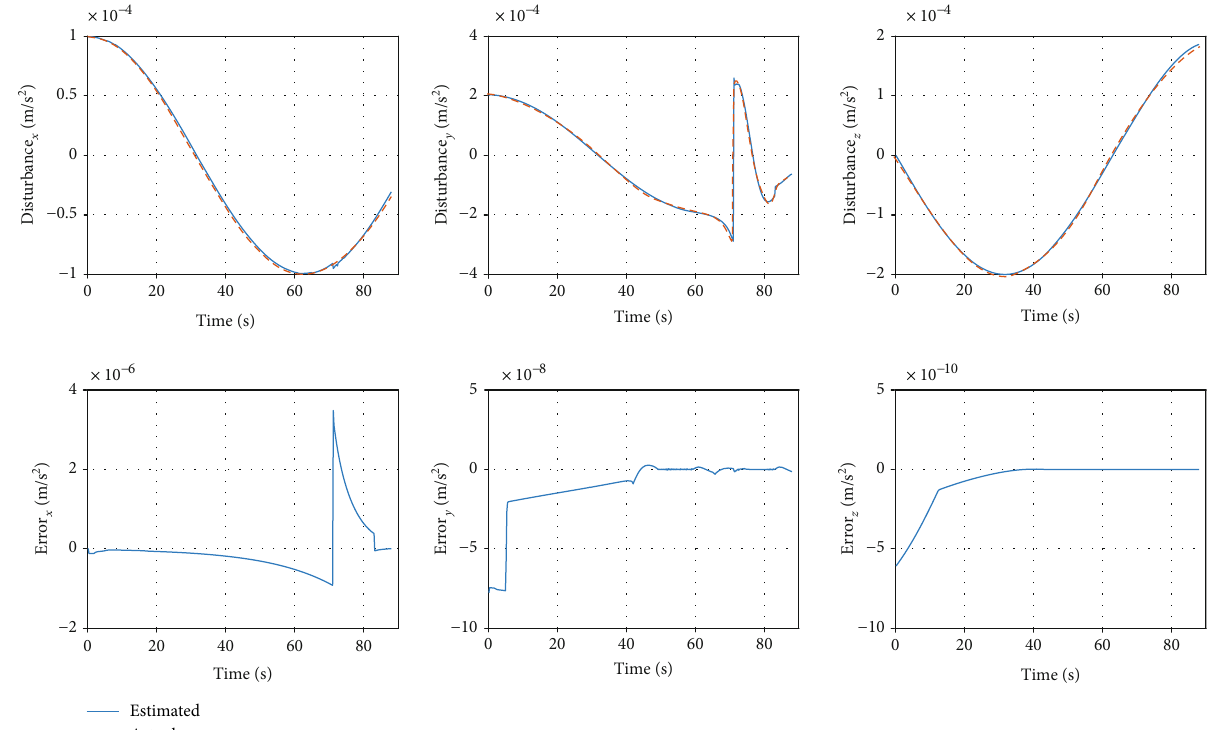
Figure 21: Tracking results of model uncertainties and unknown external